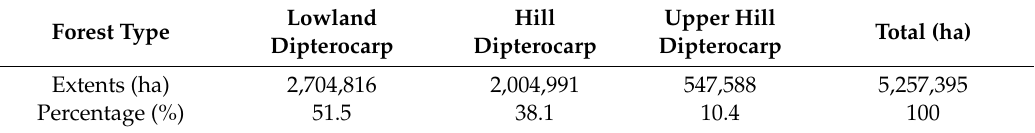
Table 6. Forest types within the study area.